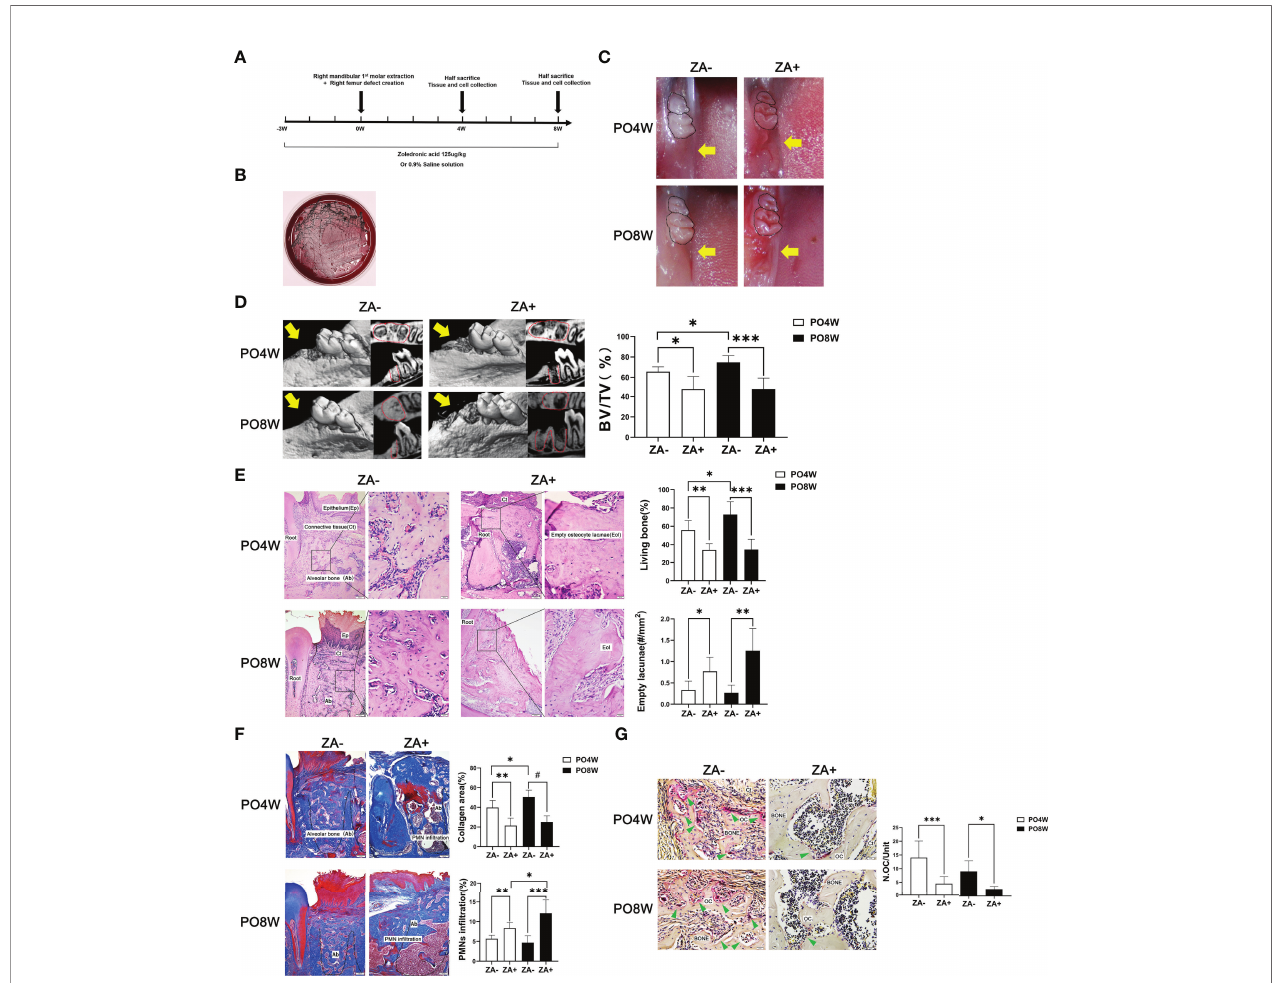
FIGURE 1 | Establishment of a mouse model and impaired healing of soft and osseous tissue at tooth extraction sites under ZA administration. (A) Establishment of a mouse model of bisphosphonate related osteonecrosis. Schematic drawing of the procedures conducted in this study. ZA (125ug/kg) or 0.9% saline solution was administered intraperitoneally two times per week from the start of the experiment until euthanasia. At the third week, all animals received surgical intervention including right mandibular fi rst molar extraction and the creation of right femur defects. Mice were euthanized at either four or eight weeks after surgery. Tissues and cells were collected for further analysis. (B) Characteristic black colonies of P. gingivalis were formed on a blood agar plate. (C) Representative images of mandibular extraction wounds. At 4 or 8 weeks postoperatively, the extraction wounds healed well (yellow arrow) in the ZA- group (M); while in the ZA+ group (M) the oral mucosa closed incompletely and open wounds (yellow arrow) were observed. (D) Representative images of axial and sagittal Micro-CT slices and three-dimensional views of the mandible extraction area at week 4 and 8 postoperatively. At 4 weeks postoperatively, bone healing and remodeling were detected in mandibles of the ZA- group (M); while little bone regeneration was observed in the ZA+ group (M). At 8 weeks postoperatively, in the ZA- group (M) the extraction sockets had remodeled completely and were fi lled with new bone; while in the ZA+ group (M) destruction and enlargement of cortical bone were detected. Quantitative evaluation is also shown. BV/TV, bone volume/tissue volume. Yellow arrows indicate the extraction sockets. (E) Representative sagittal H-E-stained sections and quantitative evaluation of the histological parameters of tooth extraction sockets (bar: 100 m m and 20 m m, 10× and 40× magni fi cation, respectively). No necrotic bone and open wound areas were noted in the ZA- group (M); in the ZA+ group (M) clustered empty lacunae were detected around the extraction sockets. (F) Representative sagittal trichrome-stained sections and quantitative evaluation of the histological parameters of mandible extraction sockets (bar: 100 m m, 10× magni fi cation). There were less collagen fi bers and more PMNs in the ZA+ group (M) compared to the ZA- group (M). (G) Representative histological TRAP-stained sections of tooth extraction sockets (bar: 20 m m, 40× magni fi cation). Statistical analysis showed that in the ZA+ group (M) the number of osteoclasts was signi fi cantly decreased. Ep, epithelium; Ct, connective tissue; Ab, alveolar bone; Eol, empty osteocyte lacunae; PMN, polymorphonuclear leukocytes; Oc, osteoclasts; PO4W, postoperative 4 weeks; PO8W, postoperative 8 weeks. *p <0.05, **p <0.01, ***p <0.001, # p